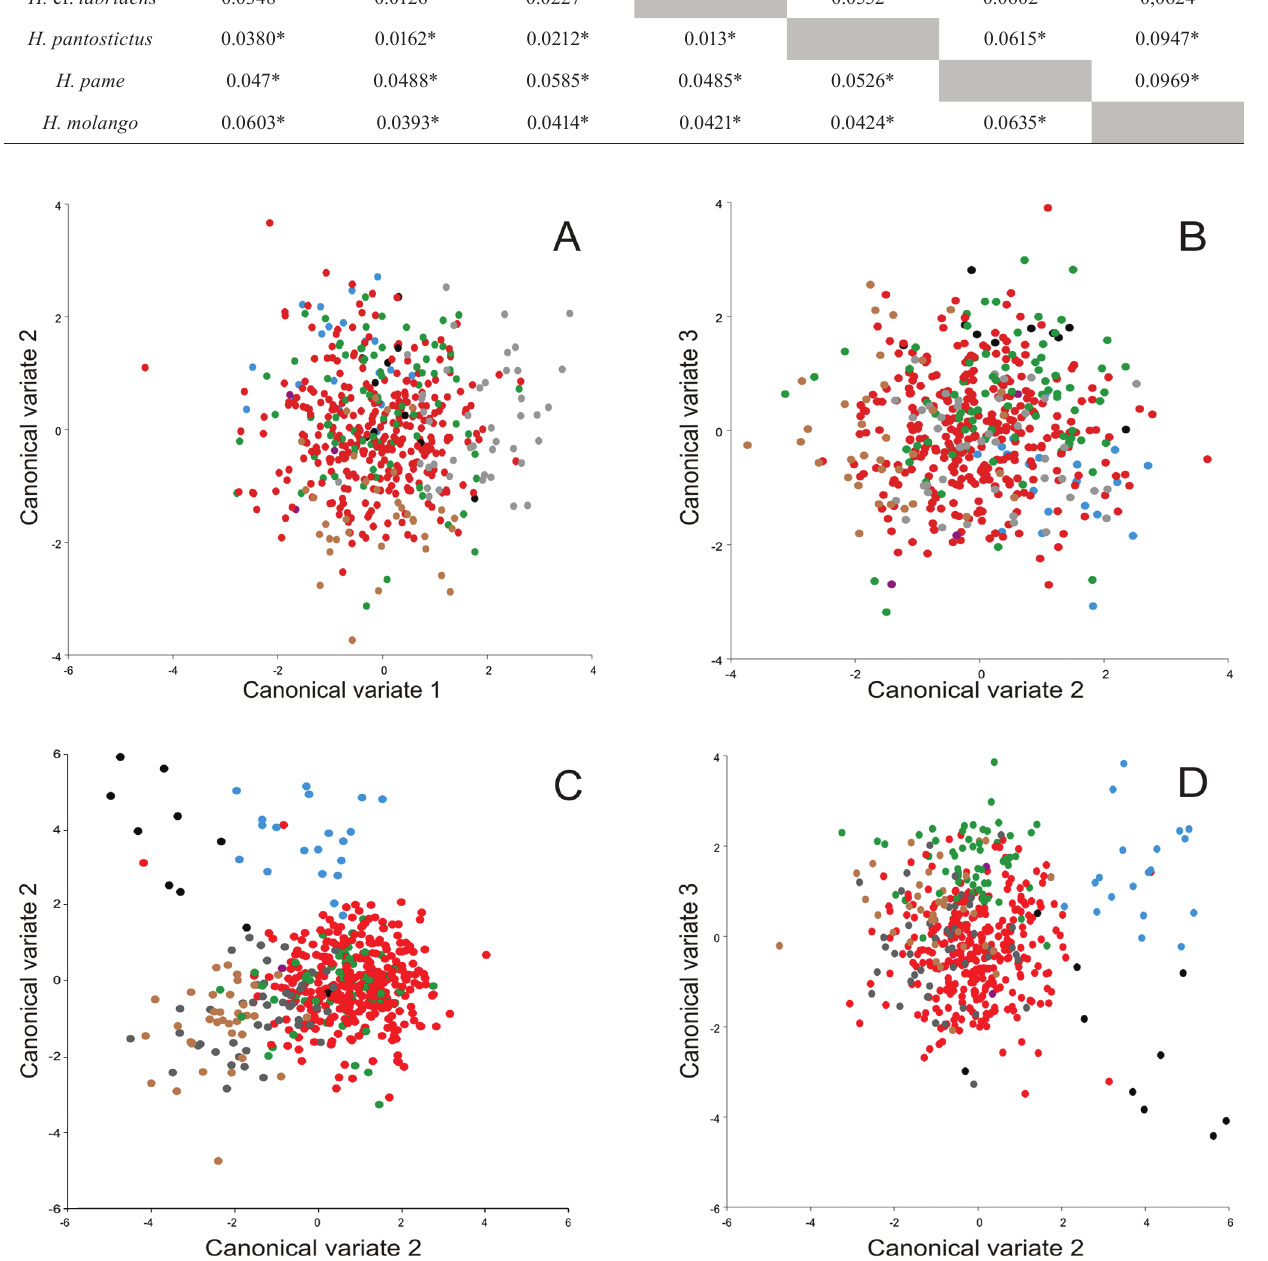
Fig. 5. Canonical variance analysis derived from the geometric morphometric analysis of the species included in the Herichthys bartoni species group. A) canonical variate 1 and 2 for the head, B) canonical variate 2 and 3 for the head, C) canonical variate 1 and 2 for the body, D) canonical variate 2 and 3 for the body. Symbology: Blue: H. bartoni , Red: H. cf. labridens , Green: H. labridens , Violet: H. molango , Black: H. pame , Gray: H. pantostictus , Brown: H. steindachneri